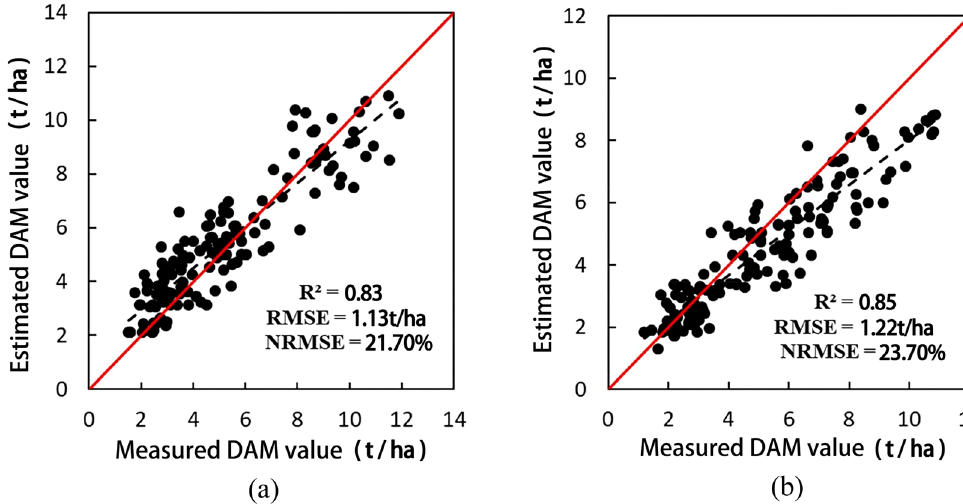
Figure 6. Scatter plots of the estimated and measured DAM values in 2014 ( a ) and 2015 ( b ).